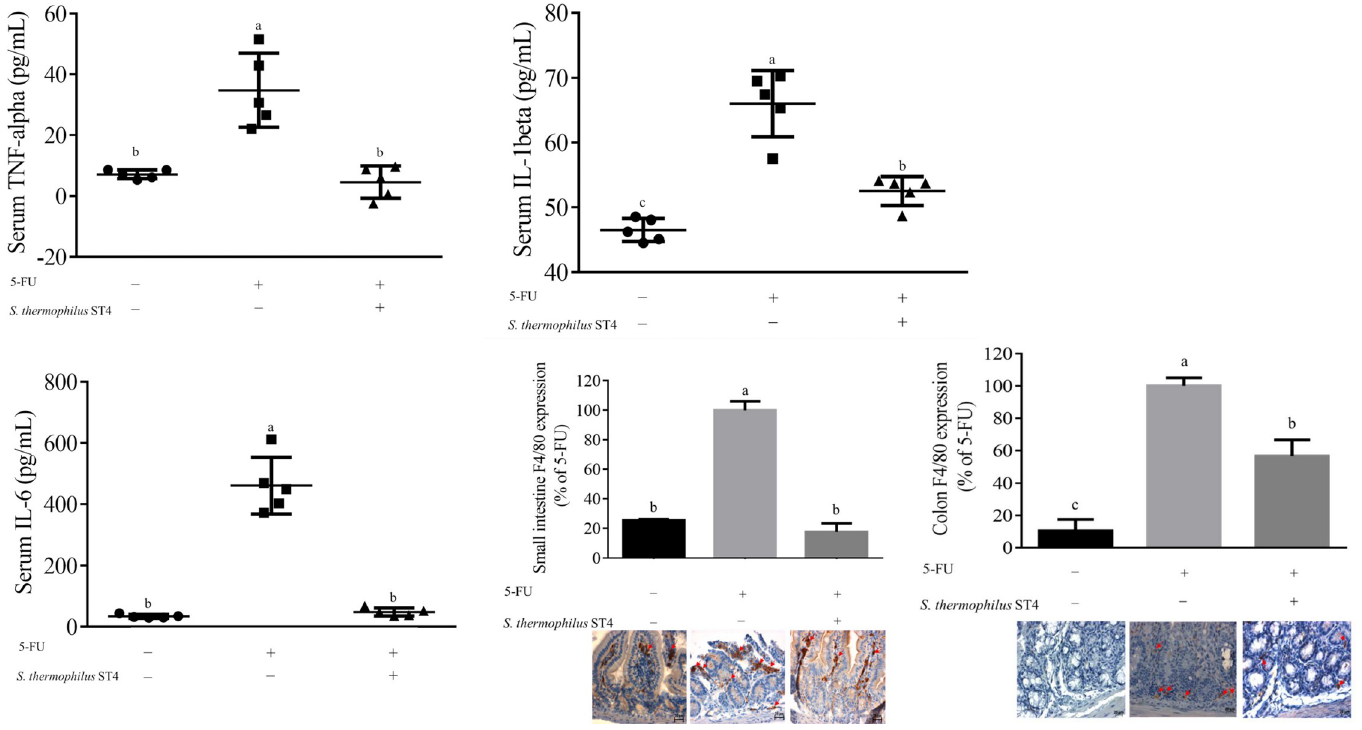
Fig 3. Reduction of the inflammatory effect by S . thermophilus ST4 in the 5-FU-induced intestinal mucositis mouse model. Despite of elevated expressions of TNF- α (A), IL-1 β (B) IL-6 (C) and F4/80 (a marker for macrophage, D and E) induced by 5-FU, S . thermophilus ST4 enabled significantly diminishing the increase of these inflammatory factors in serum or in the intestine (D) and the colon (E) of the 5-FU-induced mucositis mice. Data are present as mean ± SD. The data with different superscripted letters are significantly different based on the one-way ANOVA ( p < 0.05).